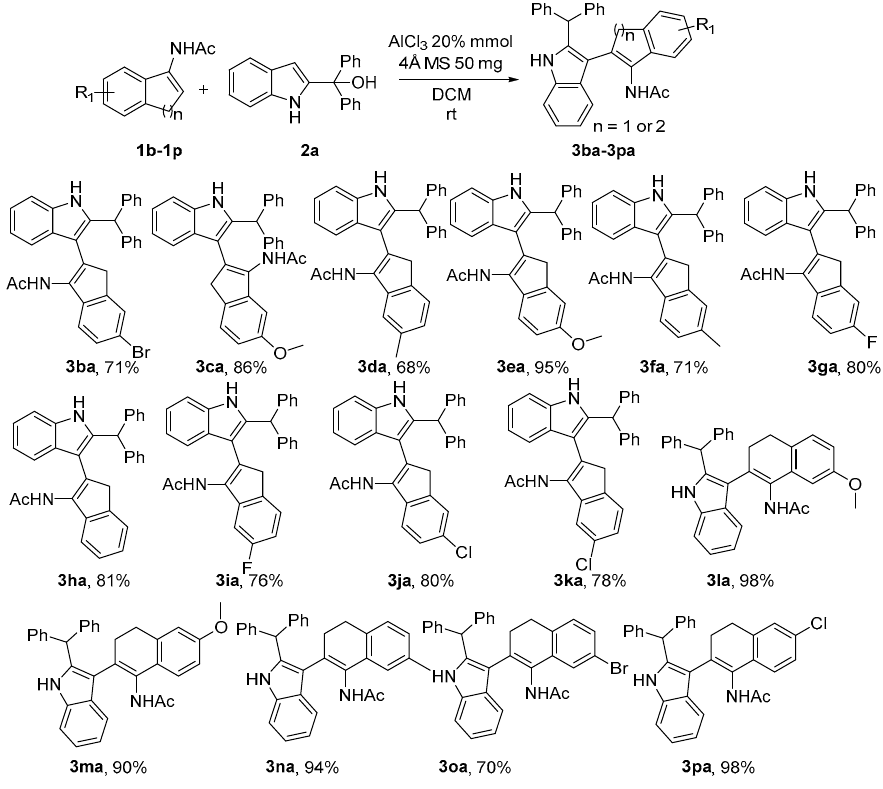
Figure 2. Scope of enamines.